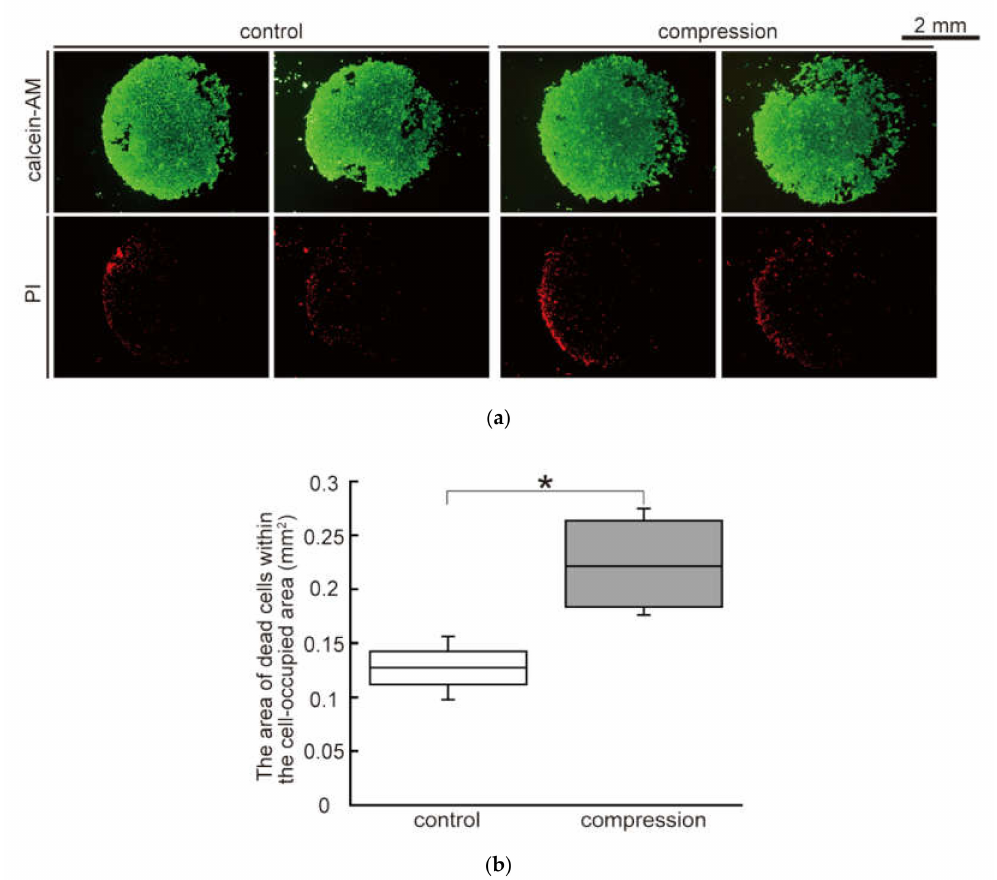
Figure 4. E ff ect of compression on cell viability in the malignant melanoma model: ( a ) Fluorescent microscopic images of B16F10 cells in the melanoma model stained by calcein-AM / PI (propidium iodide) at 32 h of culture. Live cells exposed to calcein-AM showed green fluorescence, while dead cells allowed PI to enter the cell membrane and label the cell nucleus with red fluorescence; ( b ) The area occupied by dead cells at 32 h of culture (n = 4). Experimental data were examined for significant di ff erences using Student’s t -tests. * indicates a significant di ff erence compared to control group ( p <